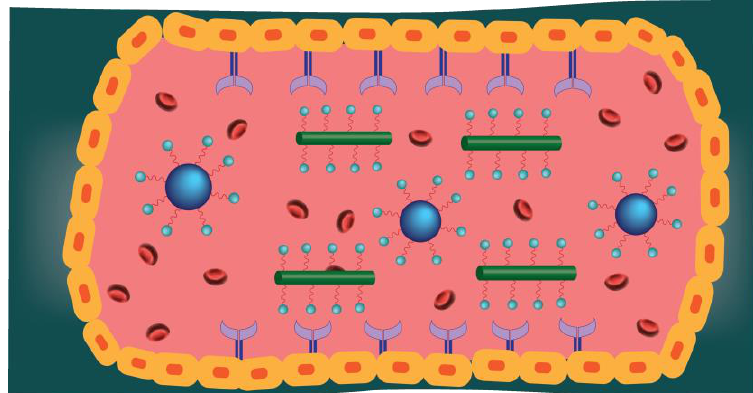
Figure 4. Effects of shape on nanoparticle flow. Spherical nanoparticles move toward the center of the flow, while the rod-shaped nanoparticles tend to attach to wall receptors due to the different forces and torques exerted on rods.